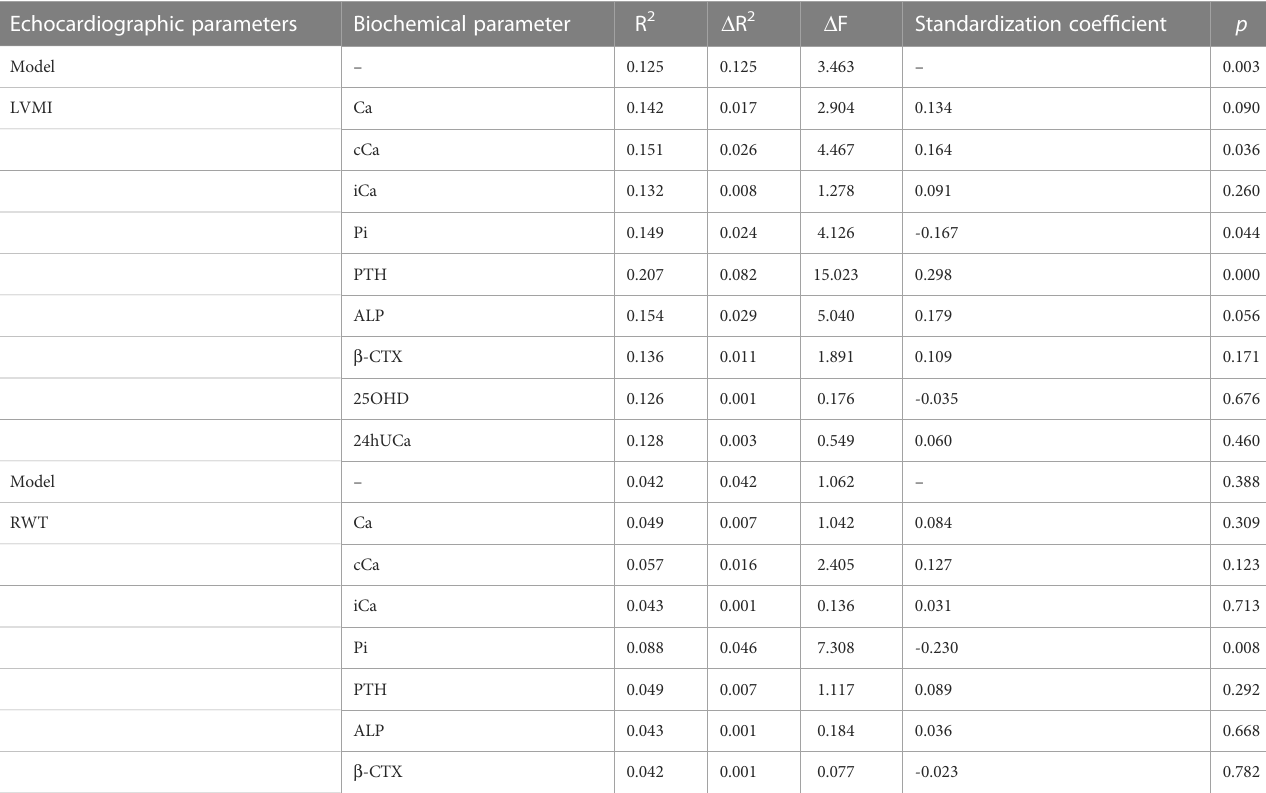
Echocardiographic